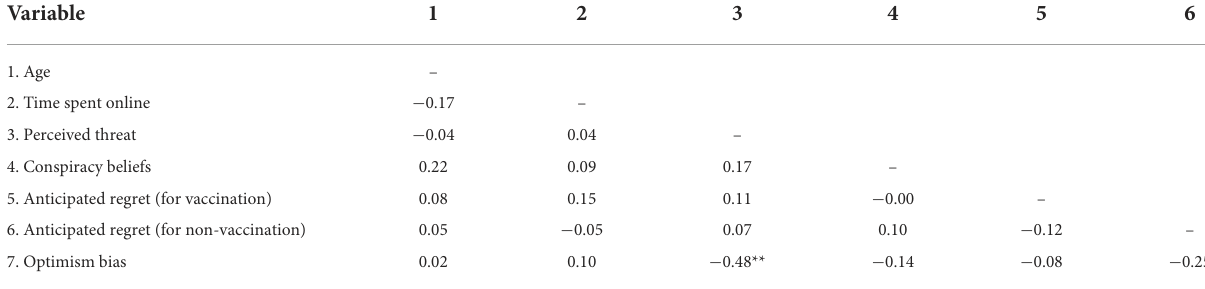
TABLE 2a Associations between the main variables ( N = 54, participants who exclude vaccination).